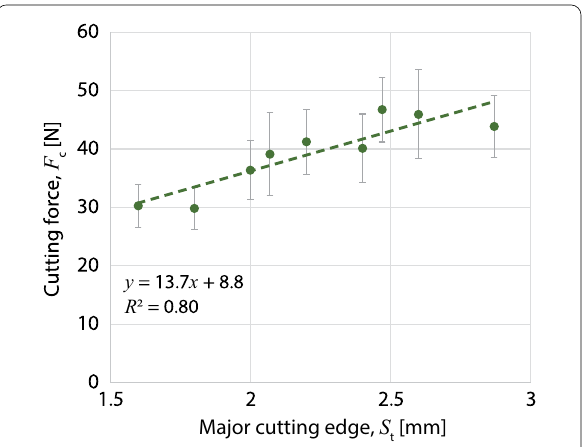
Major cutting edge, S [mm] t Fig. 8 Example of a force–width graph: a best-fit line indicates a y-intercept of 8.8 N for non-frozen Norway spruce (please note the lower limit of the x-axis). The y-intercept is an approximation of the Zone II forces ( F II